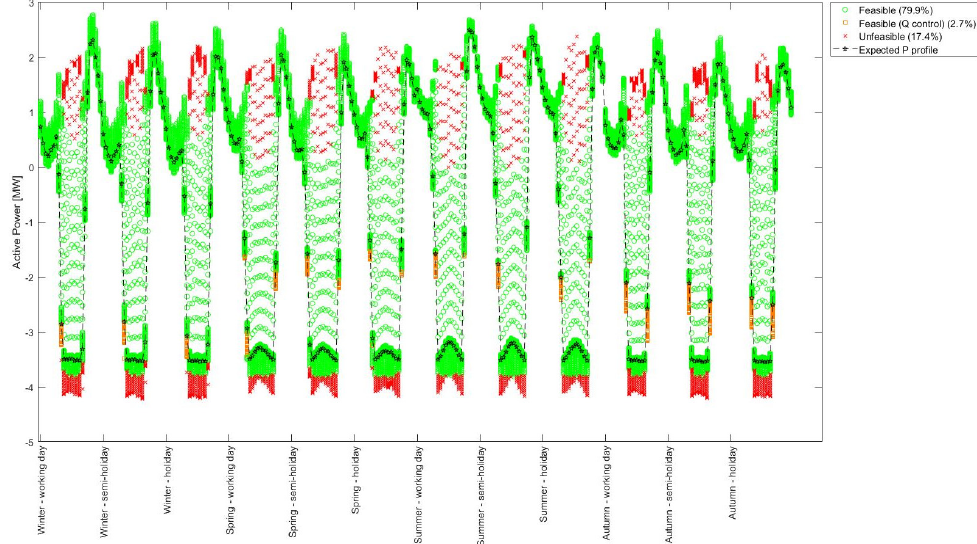
Figure 4. Potential P profile during all the representative days, feeder R1—case A (“only